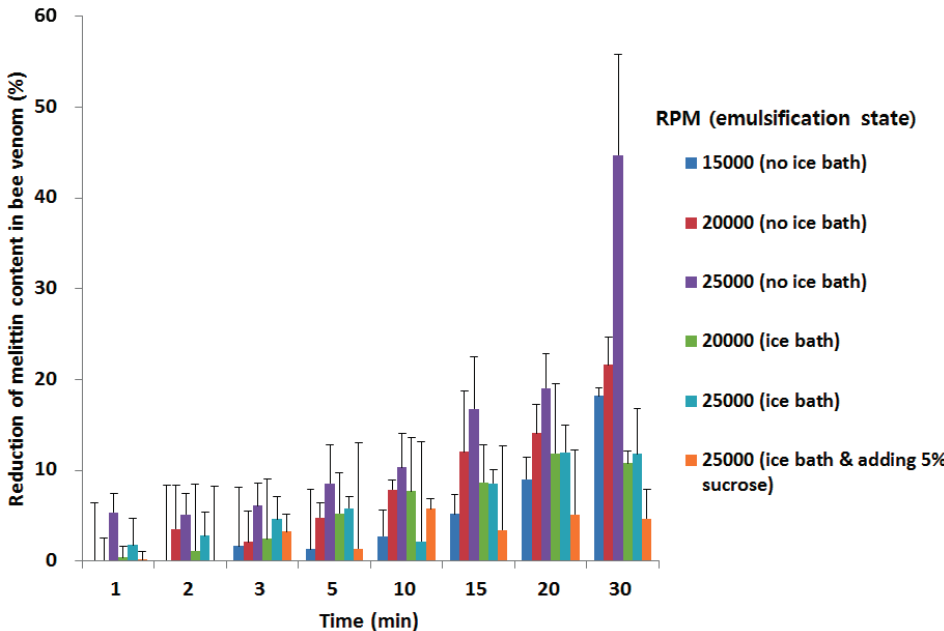
Figure 7. Effect of homogenization time and state on bee venom. Data are expressed as the mean ± SD ( n =